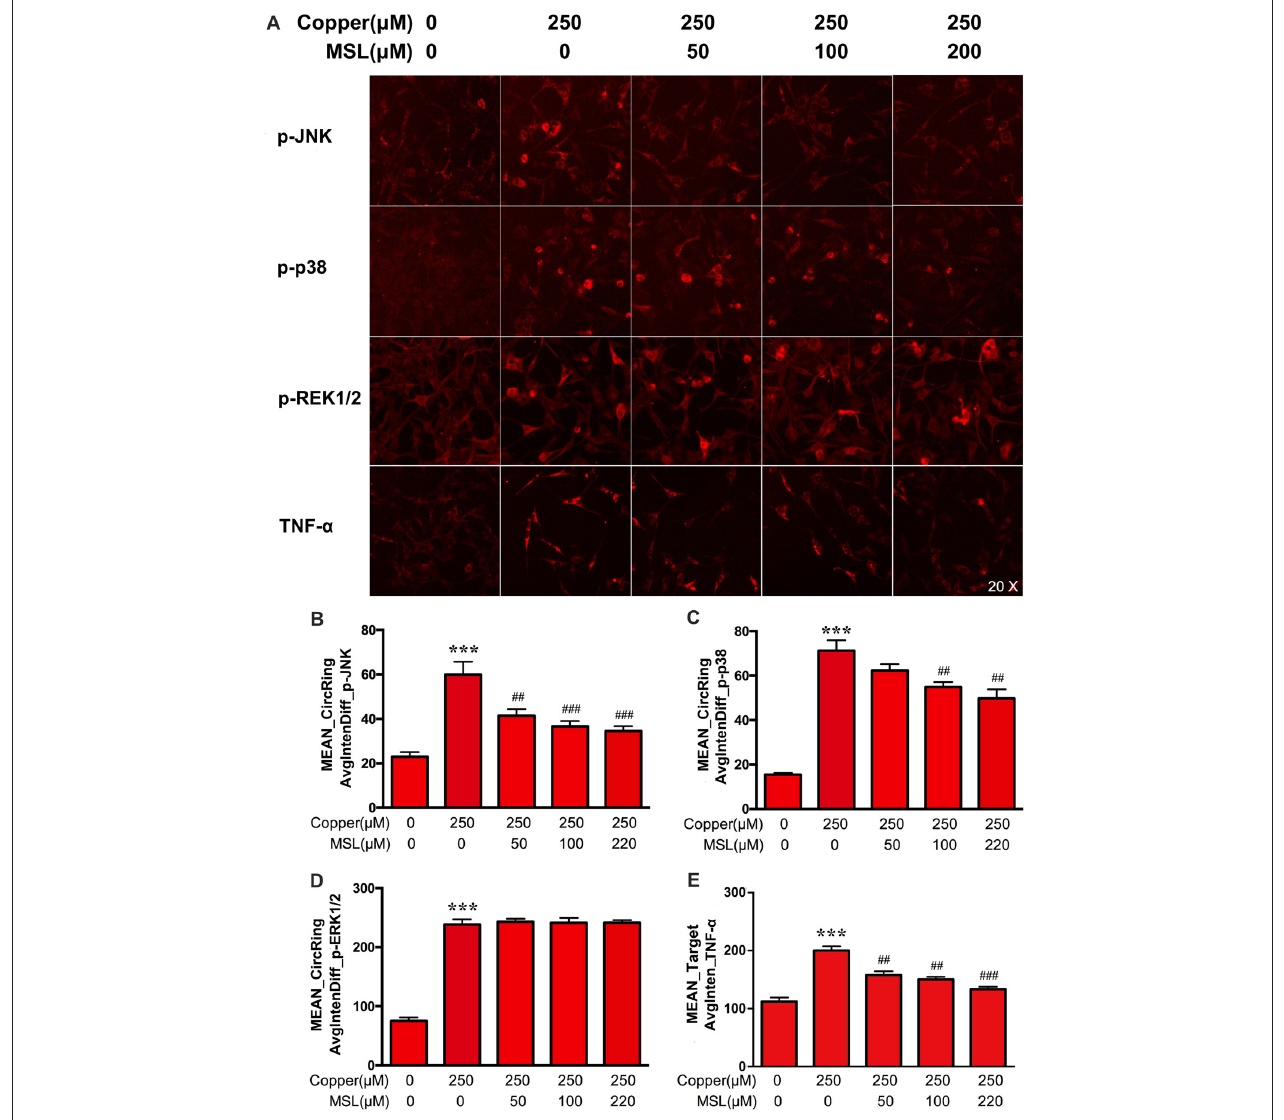
FIGURE 7 | The effect of MSL on activation of the mitogen-activated protein kinase (MAPK) signal pathway in APPsw cells. (A) Immunofluorescence analysis was used to determine the phosphorylation of c-jun n-terminal kinase (JNK), p38, ERK1/2, and the production of TNF- α by APPsw cells in the presence of copper. Fluorescent images and intensities were analyzed by a Cellomics ArrayScan high-content screening (HCS) Reader and software. Quantified values of JNK (B) , p38 (C) , ERK1/2 (D) and TNF- α (E) were analyzed by Mean_Avginten. Data are expressed as the mean ± SEM, n = 6, ∗∗∗ p < 0.001 vs. untreated cells; ## p < 0.01, ### p < 0.001 vs. copper-treated